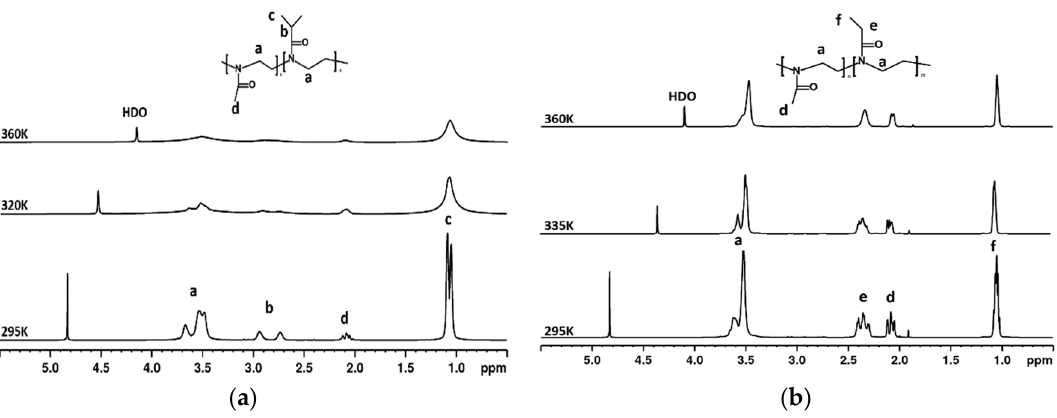
Figure 3. 600.2 MHz 1 H NMR spectra of P(MeOx/IPOx)(14/86) ( a ) and P(MeOx/EtOx)(28/72) ( b ) copolymers in D 2 O solutions (c = 5 wt%) measured at 295, 320, or 335 and 360 K under the same instrumental conditions.